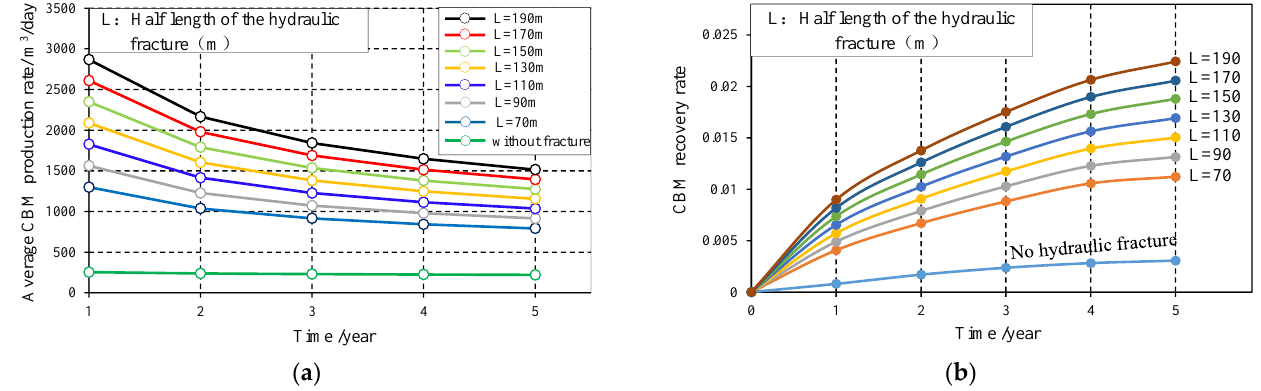
Figure 14. Average CBM production rate and CBM recovery rate of the reservoir with different fracture morphologies. ( a ) average CBM production rate and ( b ) CBM recovery rate of the reservoir.